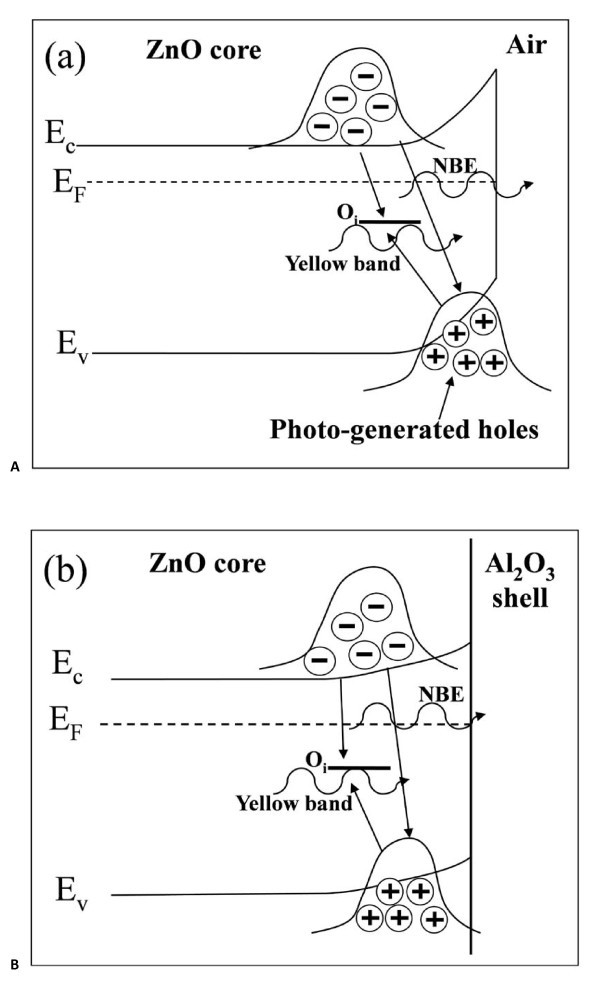
Band diagrams. Schematic band diagrams of (a) as-grown ZnO NRAs and (b) ZnO/Al2O3 core-shell NRAs.